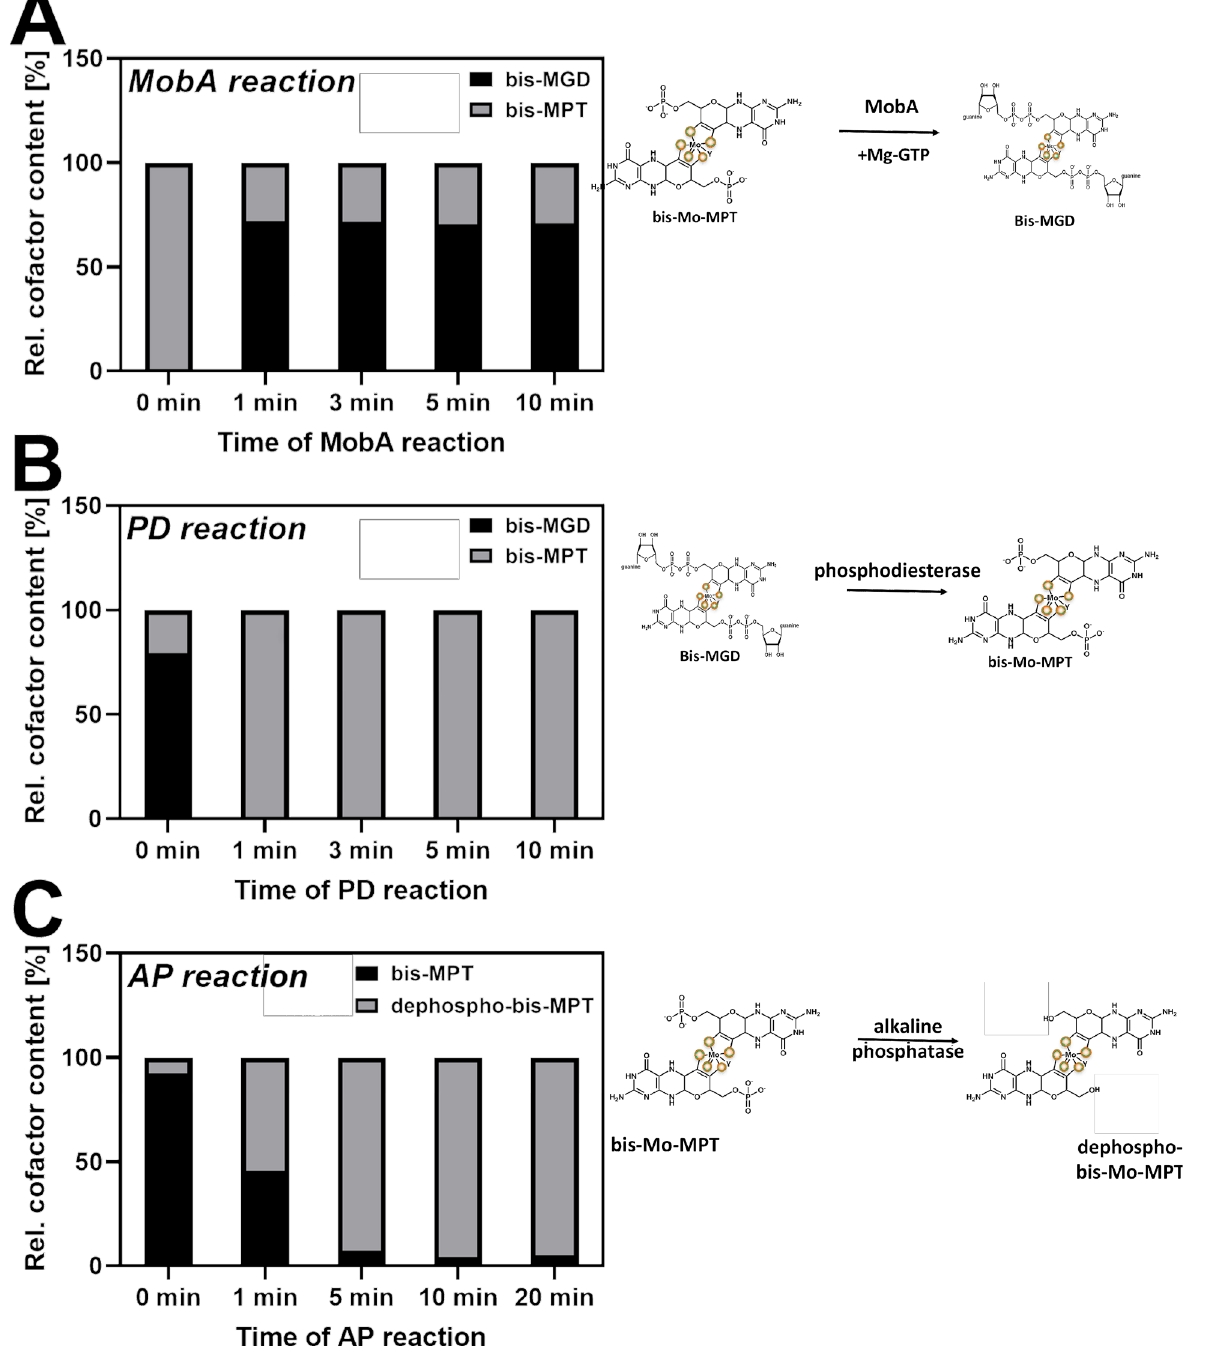
Figure 2. Conversion efficiency over time for enzymatic conversion of cofactors. ( A ) Conversion of bis-MPT from 30 µM YdhV to bis-MGD catalyzed by 3 µM MobA in presence of 1 mM GTP and 1 mM MgCl 2 . ( B ) Conversion of bis-MGD from 30 µM wtTorA to bis-MPT catalyzed by 10 U/mL phosphodiesterase I (PD). ( C ) Conversion of bis-MPT from 30 µM YdhV to dephospho-bis-MPT catalyzed by 10 U/mL alkaline phosphatase (AP). The reactions were terminated by the addition of acidic I 2 /KI solution. The cofactors were quantified in form of their fluorescent oxidation products FormA-GMP and dephospho-FormA. On the right-hand side next to the panels, a scheme is shown of the enzymatic reaction that was performed to convert the cofactor into a different form. In addition, we used BSA as background control for unspecific Moco